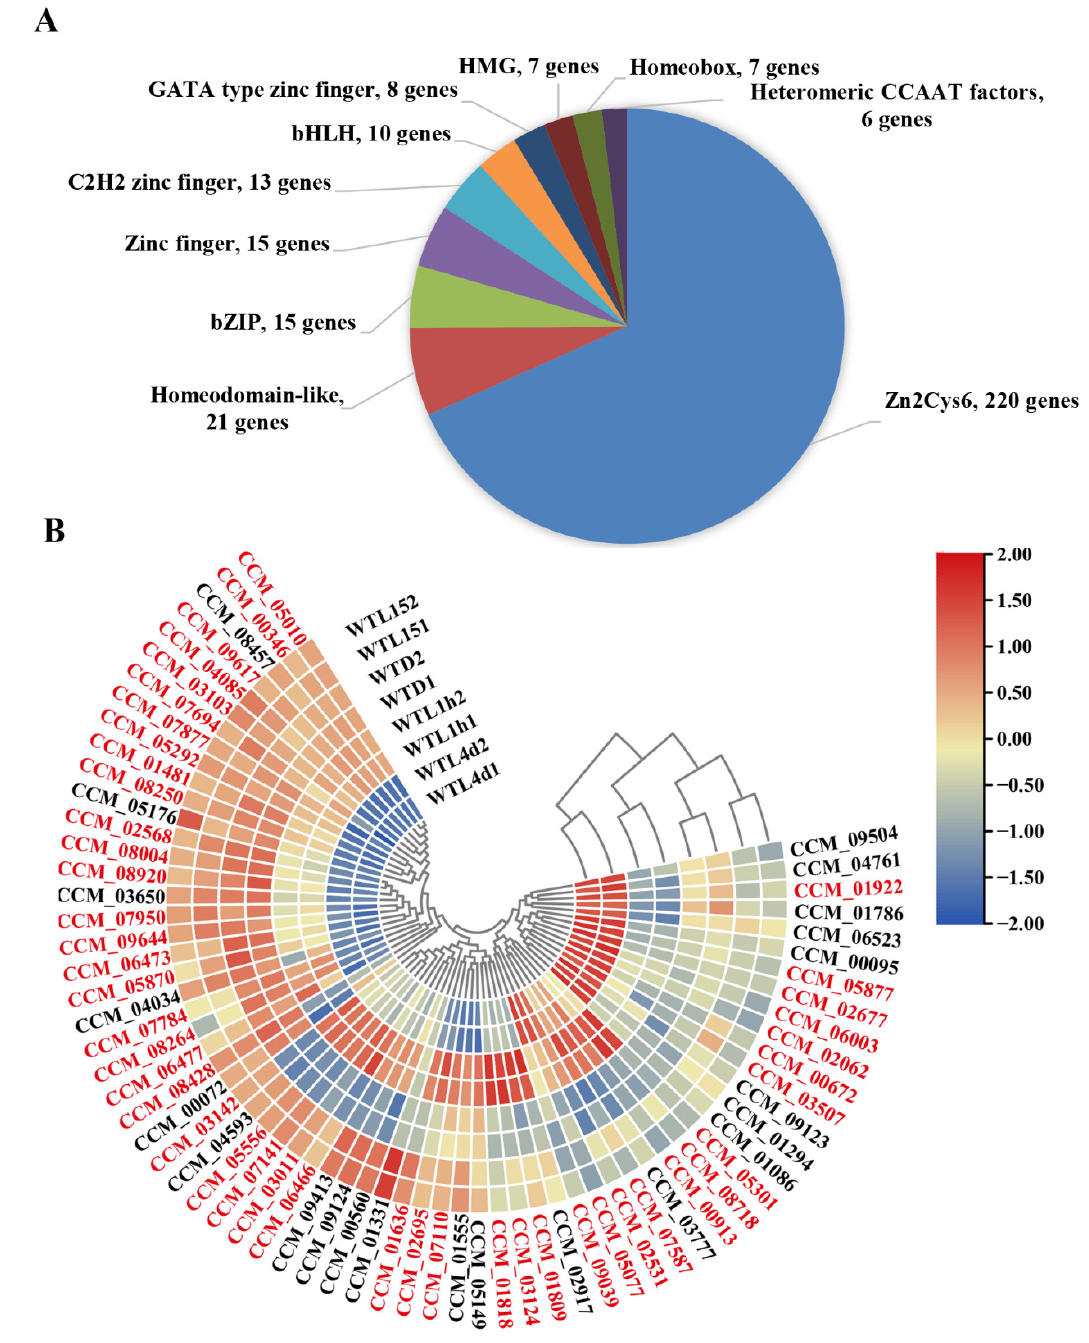
Figure 4. Distribution of transcription factors into major classes and heatmap for differentially expressed transcription factors in Cordyceps militaris . Each “slice” of the pie represents the class with a gene number of transcription factor more than 5. The number of transcription factor genes in each class is indicated ( A ). Each column represents expression values normalized by log2 (FPKM+1) at the indicated samples. Genes with similar patterns of expression are clustered together. The genes belonging to the Zn2Cys6 type have been marked with red ( B ).